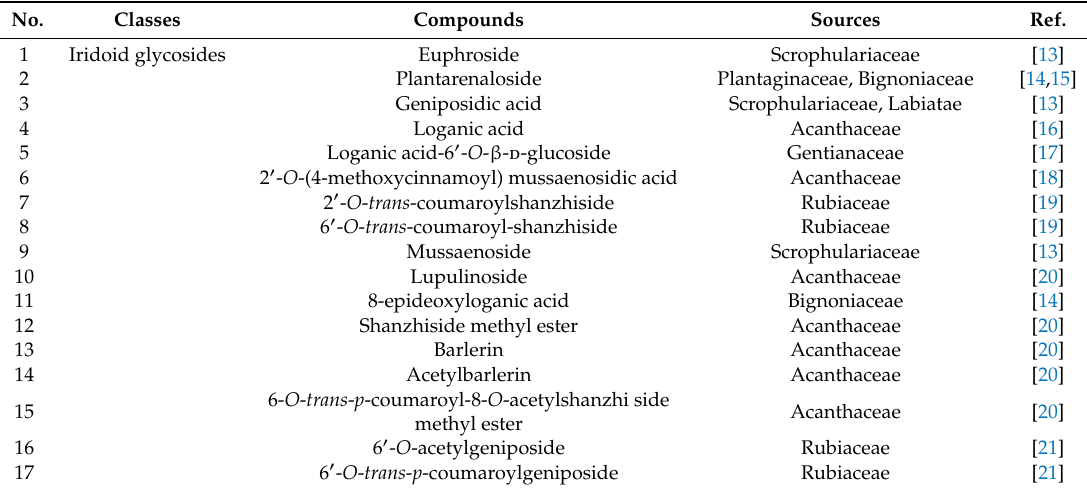
Figure 1. Three basic skeletons of iridoids. Table 1. Active iridoids compounds from 2009 to 2019.